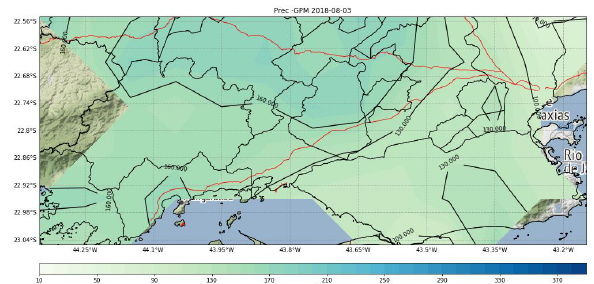
Figure 6. Accumulated daily rainfall shown as shaded and black contour lines with red lines representing pipeline transmissions. Date 2018-08-03.